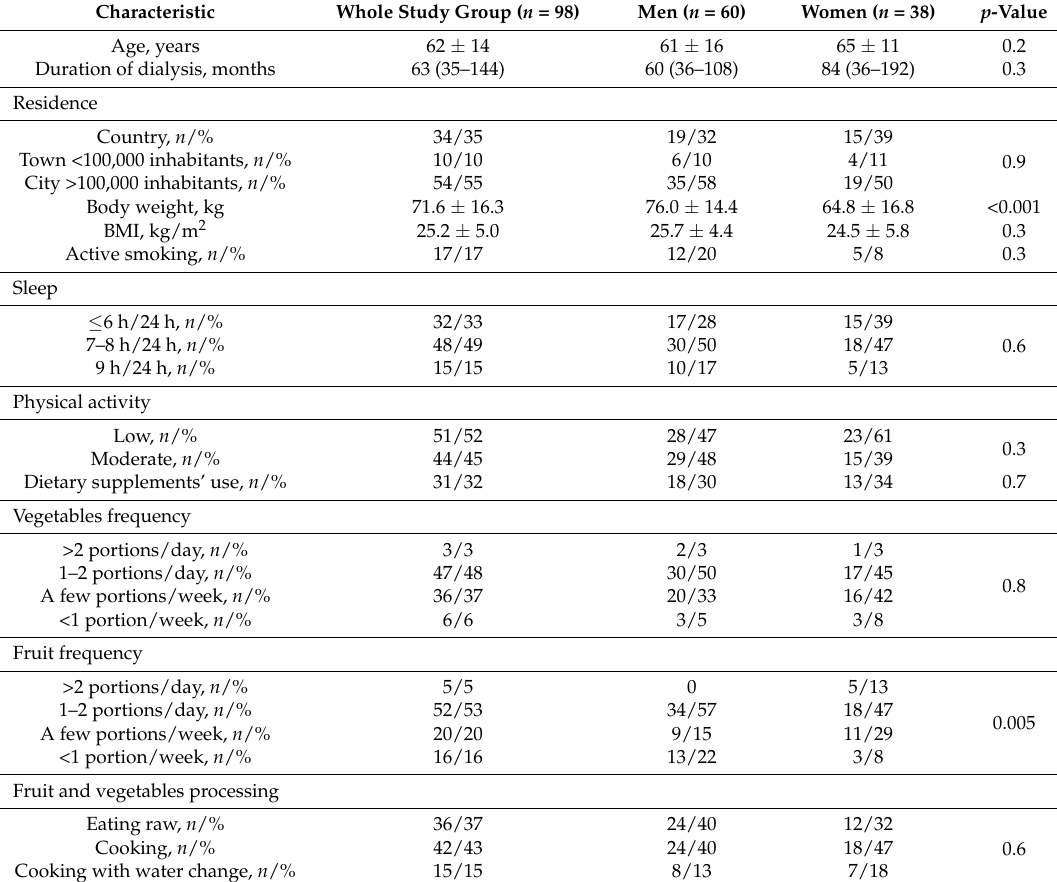
Table 1. Demographic characteristics, lifestyle, and overall fruit and vegetables consumption frequency of the study group.